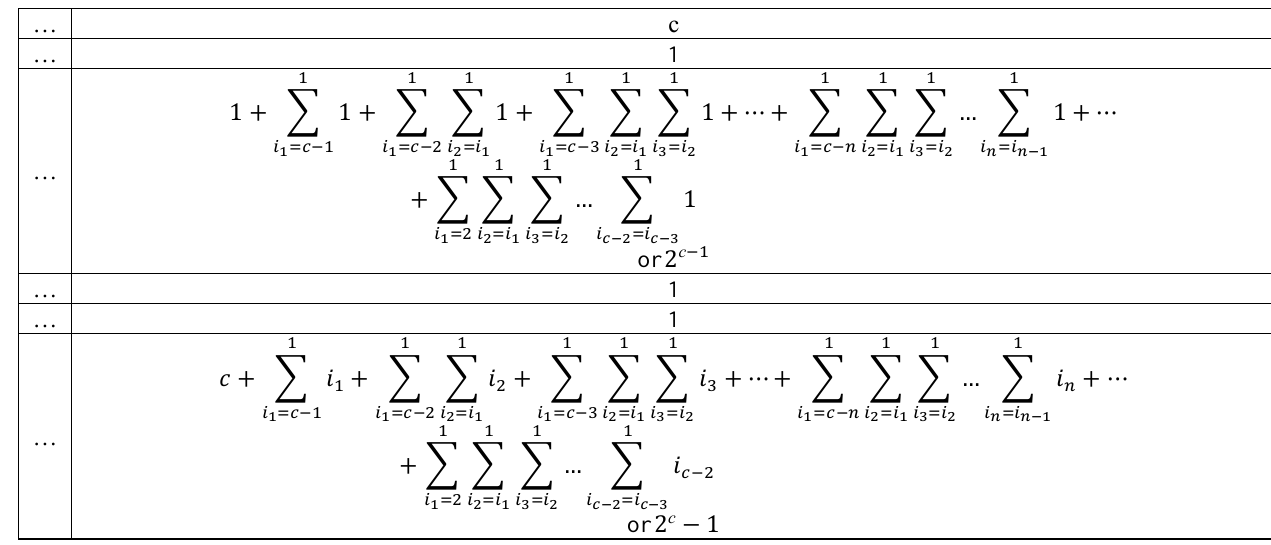
Table 3. Formation of an individual (table 2